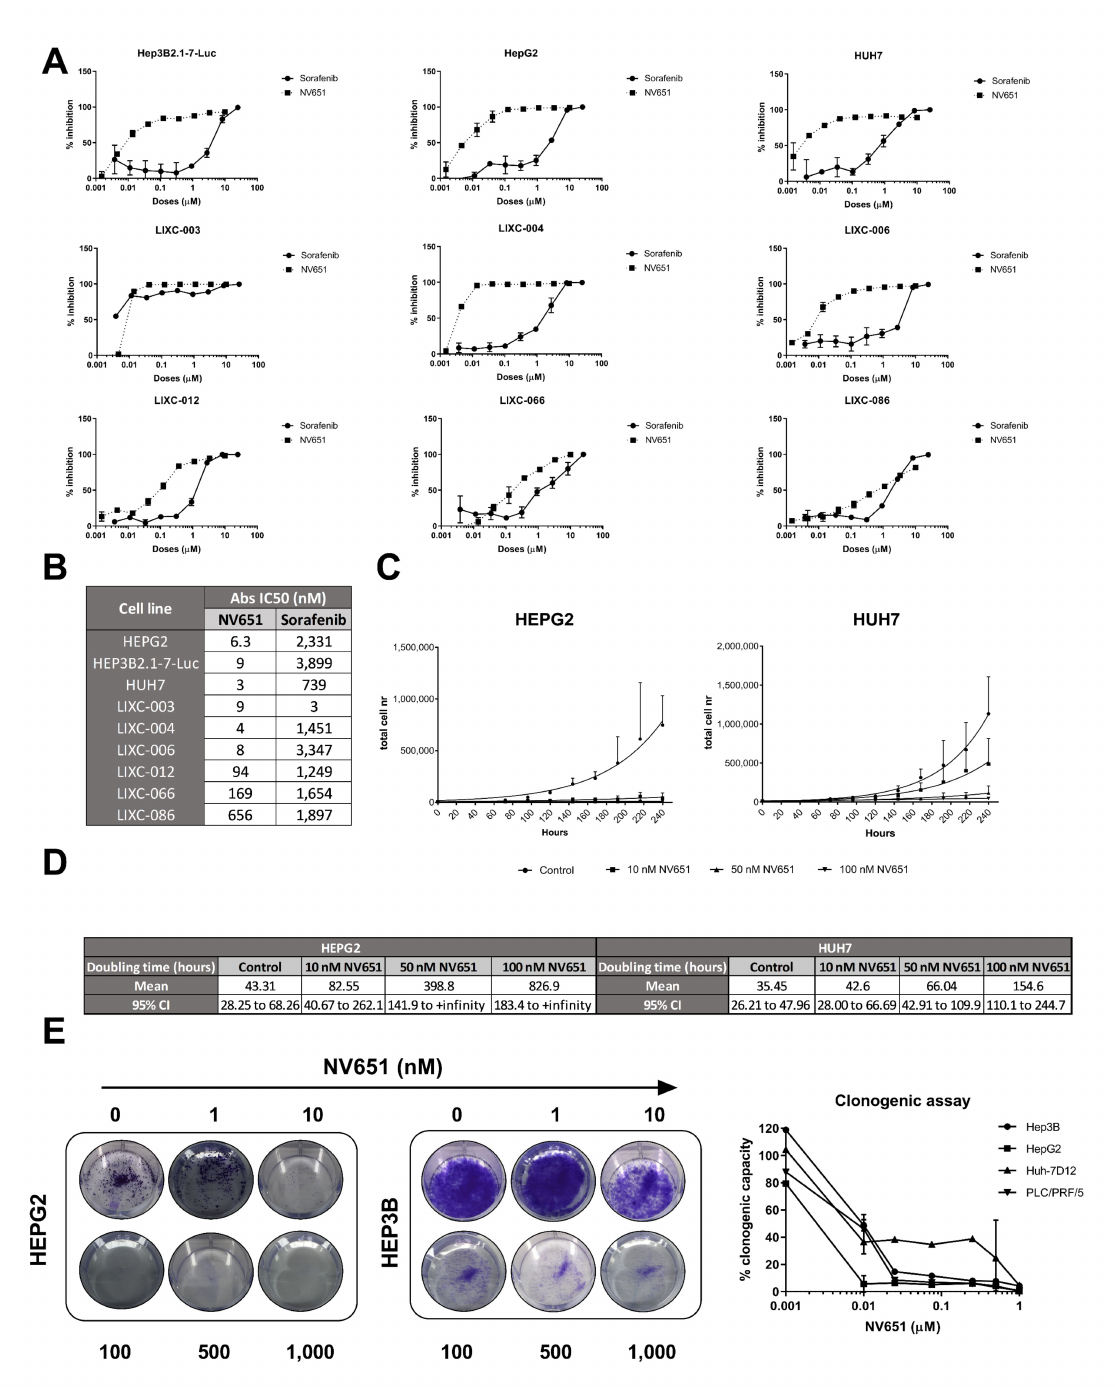
Figure 4. NV651 effect on cell proliferation. ( A ) Hep3B2.1-7-Luc, HepG2, HUH7, LIXC-003, LIXC-004, LIXC-006, LIXC-012, LIXC-066 and LIXC-086 were seeded in duplicate and treated for 7 days with the indicated drugs at different doses. ( B ) The table indicates the IC 50 values for the different drugs in the different cell lines. ( C ) NV651 effect on HEPG2 and HUH7 cells for a treatment period of 10 days. The total cell number was quantified from 3 to 10 days and presented with cell growth curves, n = 3 to 4 biological replicates. ( D ) Doubling times: mean + 95% CI calculated from the growth curves in ( C ). ( E ) NV651 effect on the colony formation in Hep3B, HepG2, Huh-7D12 and PLC/PRF/5 seeded in triplicate and continuously treated at different doses for 14 days and stained with crystal violet. Data are presented as the mean ±